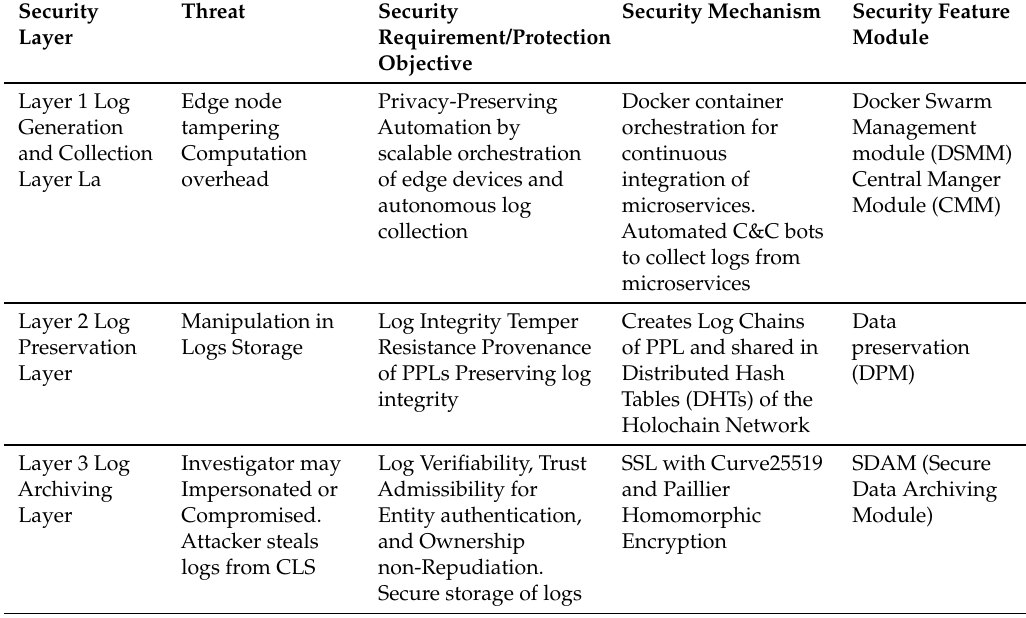
Table 3. PLAF security